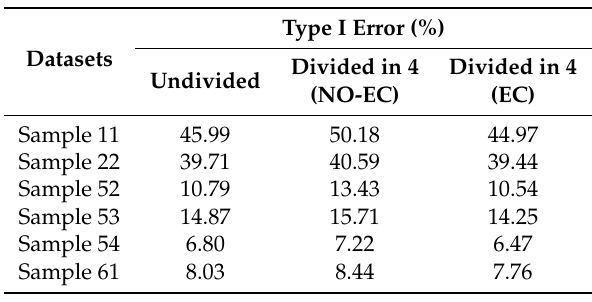
Table 3. Type I error comparison (lower is better) between EC and NO-EC using some of the datasets provided by the ISPRS